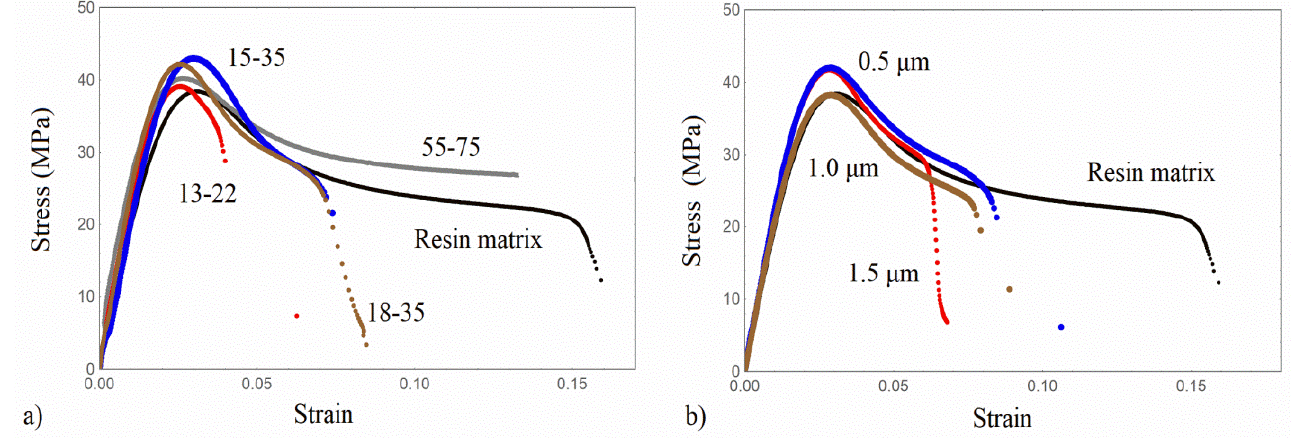
Figure 6. Tensile stress-strain curves of ( a ) Resin/silica nanocomposites, ( b ) Resin/silica micro-composite. Table 2. Tensile properties of the composites